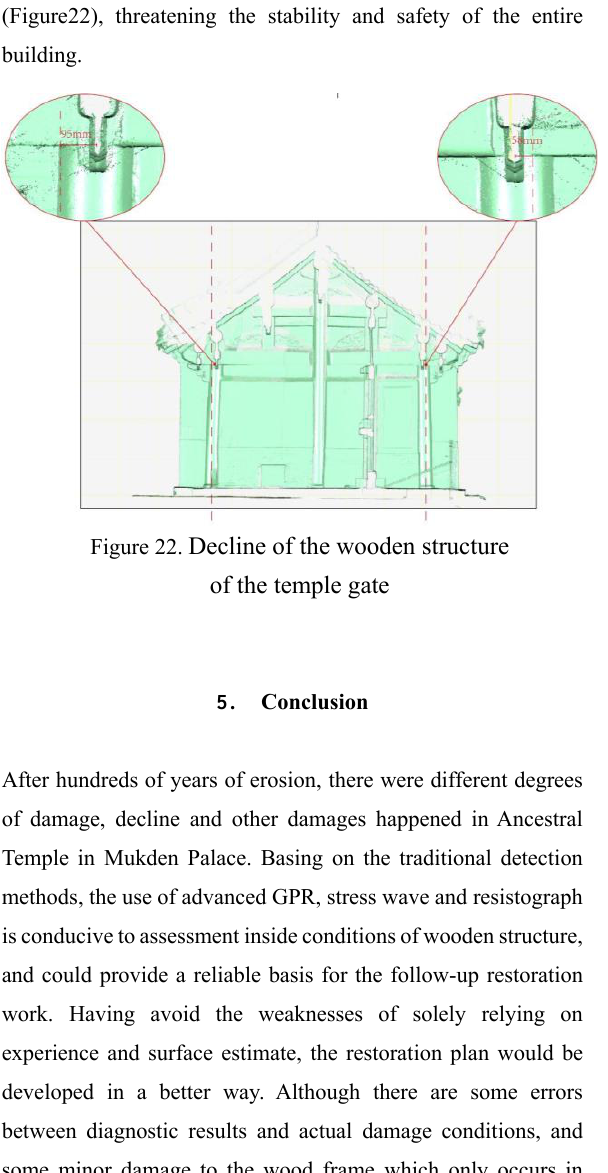
Figure 1 ： Shenyang Imperial Palace Museum